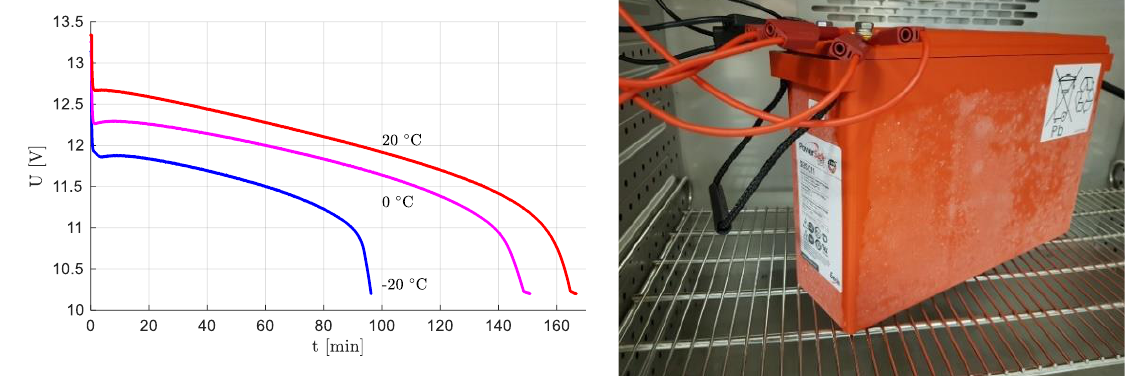
Figure 7. Measurements of the battery capacity at different surrounding temperatures (author: Petr Procházka).